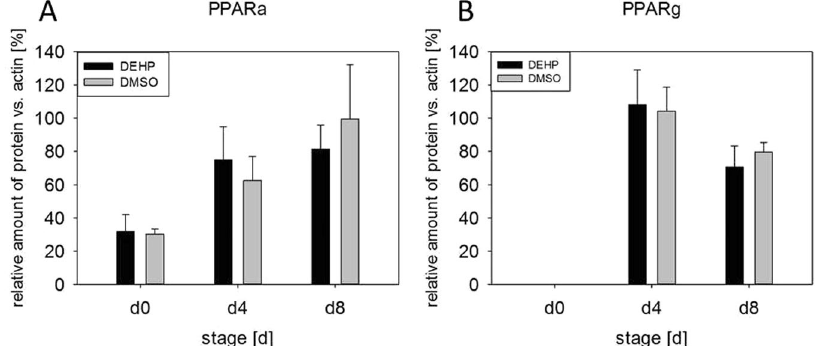
Figure 7. Protein amount of PPAR α and PPAR γ after DEHP-exposure: SGBS cells were exposed to DEHP from d0-d4 and subsequently differentiated into adipocytes. For western blot analysis of PPAR α ( A ) and PPAR γ ( B ) samples were taken at d0, d4 and d8 of differentiation. Statistics: Student’s t-test (Wilcoxon rank-sum test); N ≥ 4, n = 1 (4 pooled wells each).